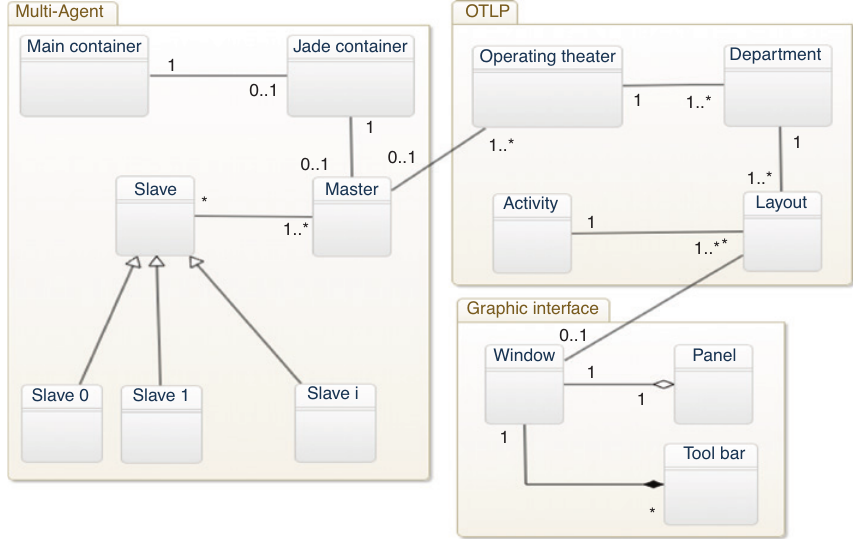
Figure 5: MAS Package